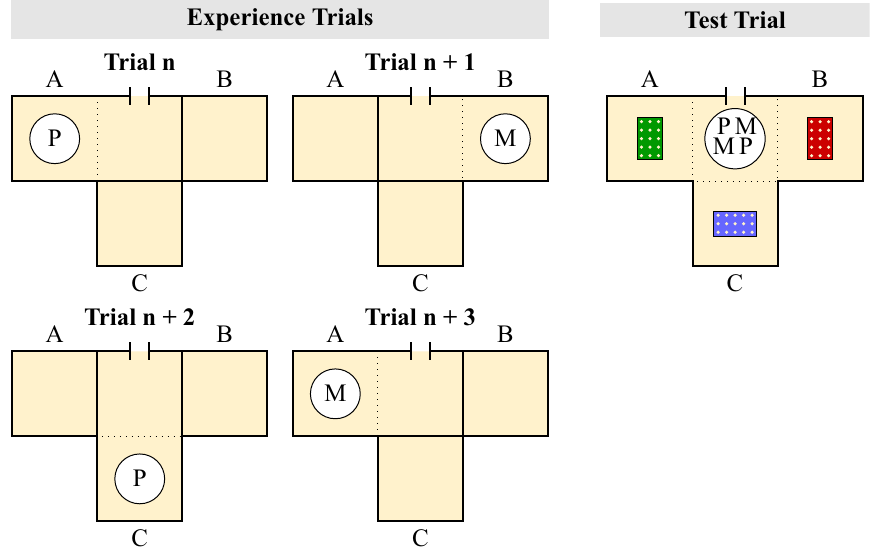
Figure 2. Top view of the experimental set-up of Experiment 1. Birds could access the three test compartments (A, B, C) from a middle compartment. On each experience trial (Left), the bird had access only to one test compartment (e.g., A in Trial n; B in Trial n+1), and one type of food in powdered form (e.g., Peanuts (P) in Trial n; Macadamia nuts (M) in Trial n+1). The compartment that was accessible and food available rotated respectively on a 3-days cycle and on a 2-days cycle. On the test trial (Right), a bowl containing items of both types of food was placed in the middle compartment and caching trays were placed in all test